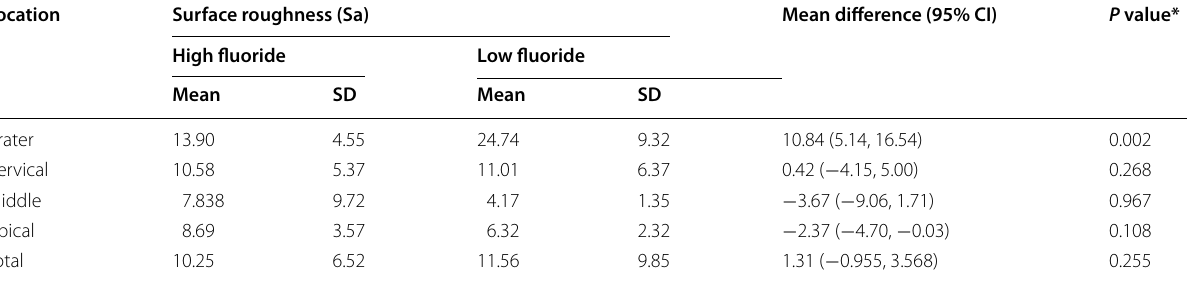
* P values from one-way ANOVA with log transformation of Sa values (logSa)